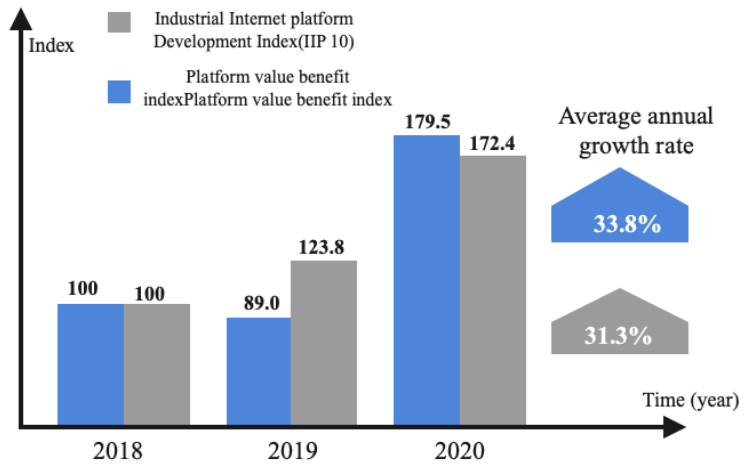
Figure 9. Change trend of platform value benefit index from 2018 to 2020.